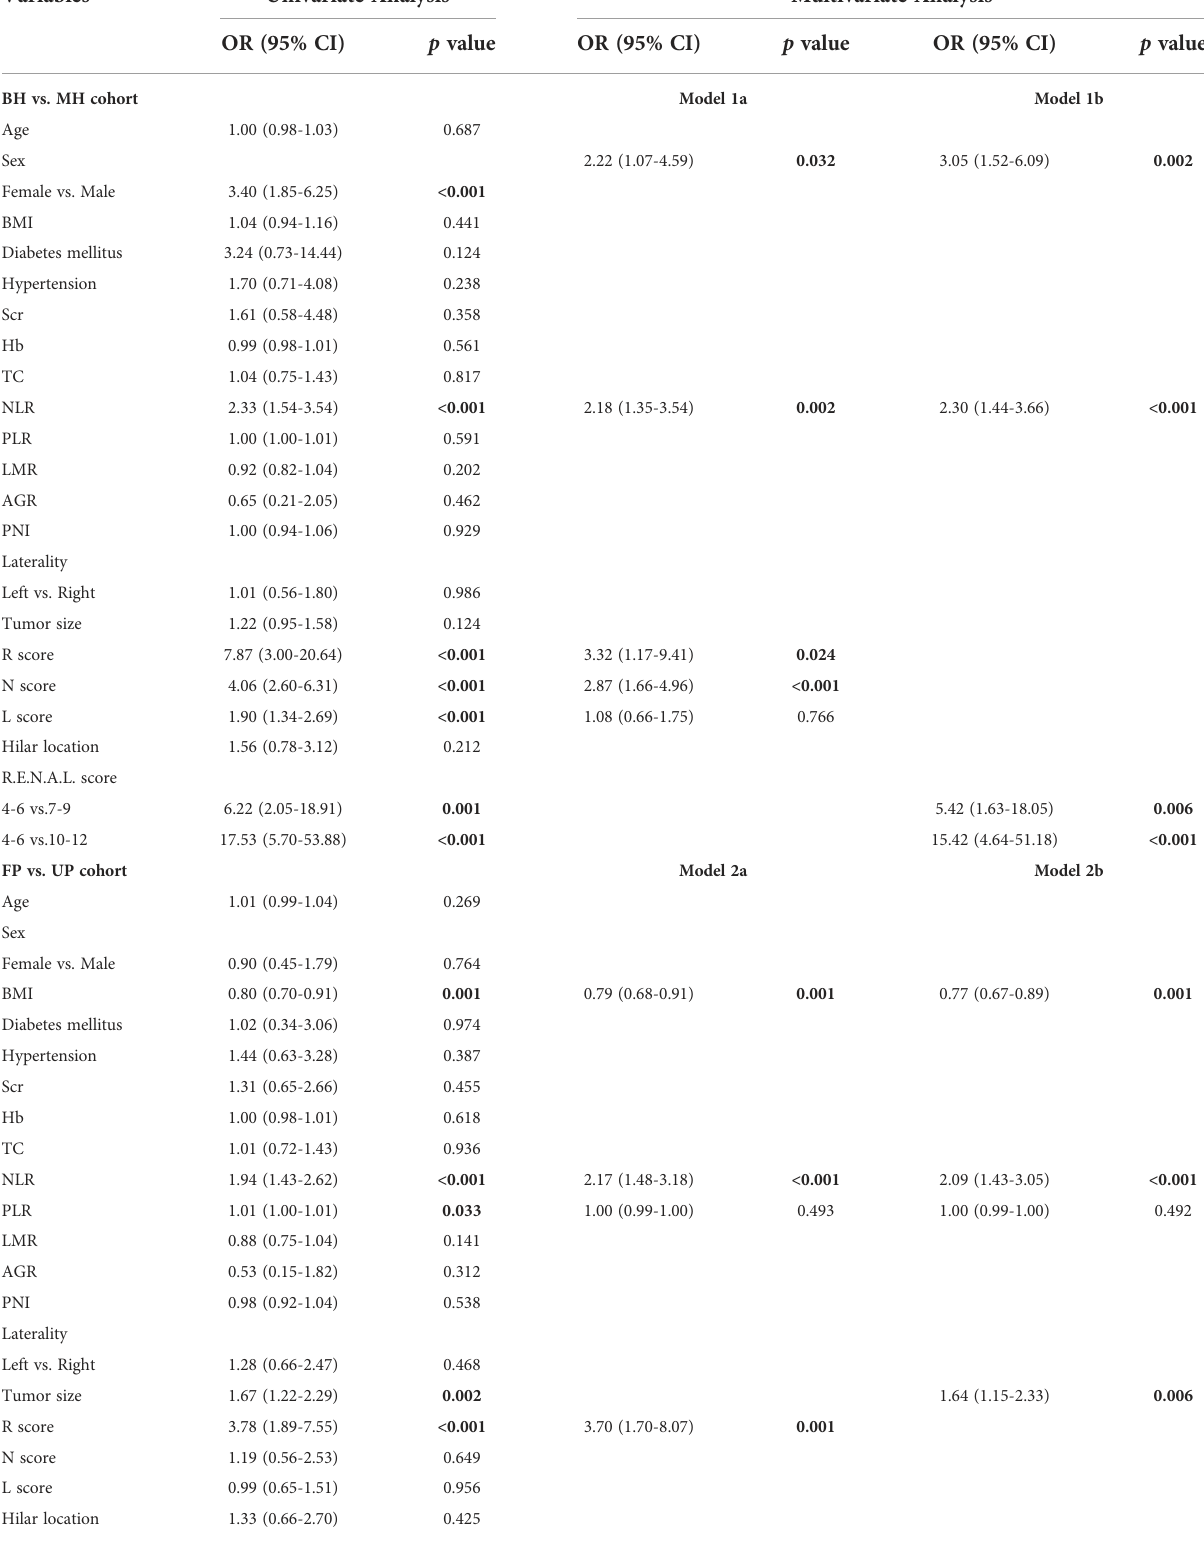
TABLE 3 Univariate and multiple logistic regressions evaluating the relationship of demographic and clinical characteristics with MH and